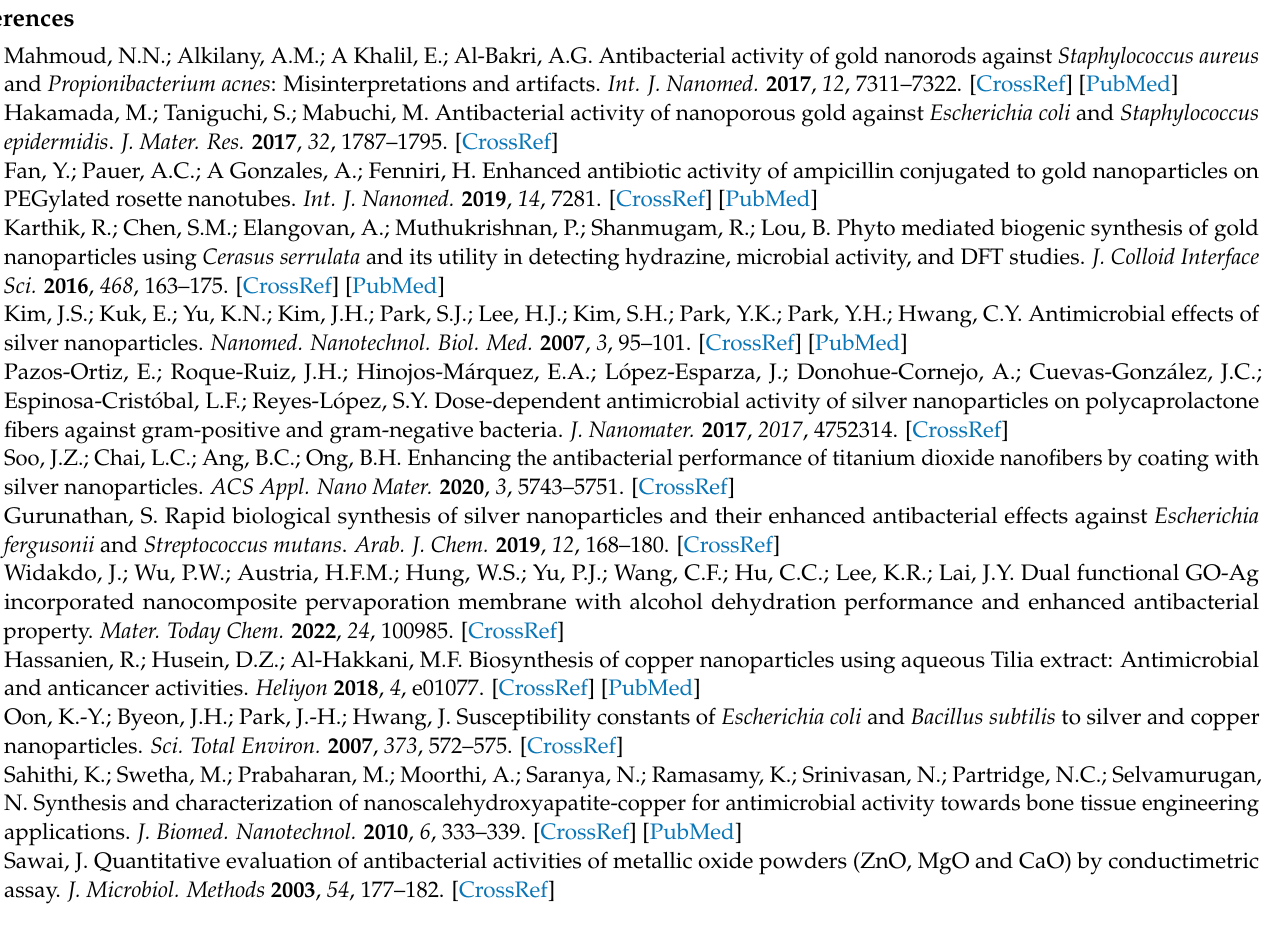
ysis of LLDPE added with different concentrations of CaCO 3 series modified metal ions; Table S3: The atomic percentage of LLDPE/CaO data from EDX measurement; Table S4: Position of crystalline peaks and crystal indices for LLDPE and LLDPE nanocomposites with different ratios of CaO/Ag, Zn, Cu nanoparticles; Table S5: Thermogravimetric analysis (TGA) analysis data of LLDPE and LLDPE biocomposites with different ratios of CaO/Ag, Zn, Cu nanoparticles; Table S6: antibacterial activity ( Escherichia coli and Staphylococcus aureus ) of powder CaO-Metal ions; Table S7: Antibacterial efficacy (%) E. coli of LLDPE/CaO 1% and LLDPE/CaO 2% with a deferent metal ion; Table S8 [54,55]: Classification antimicrobial